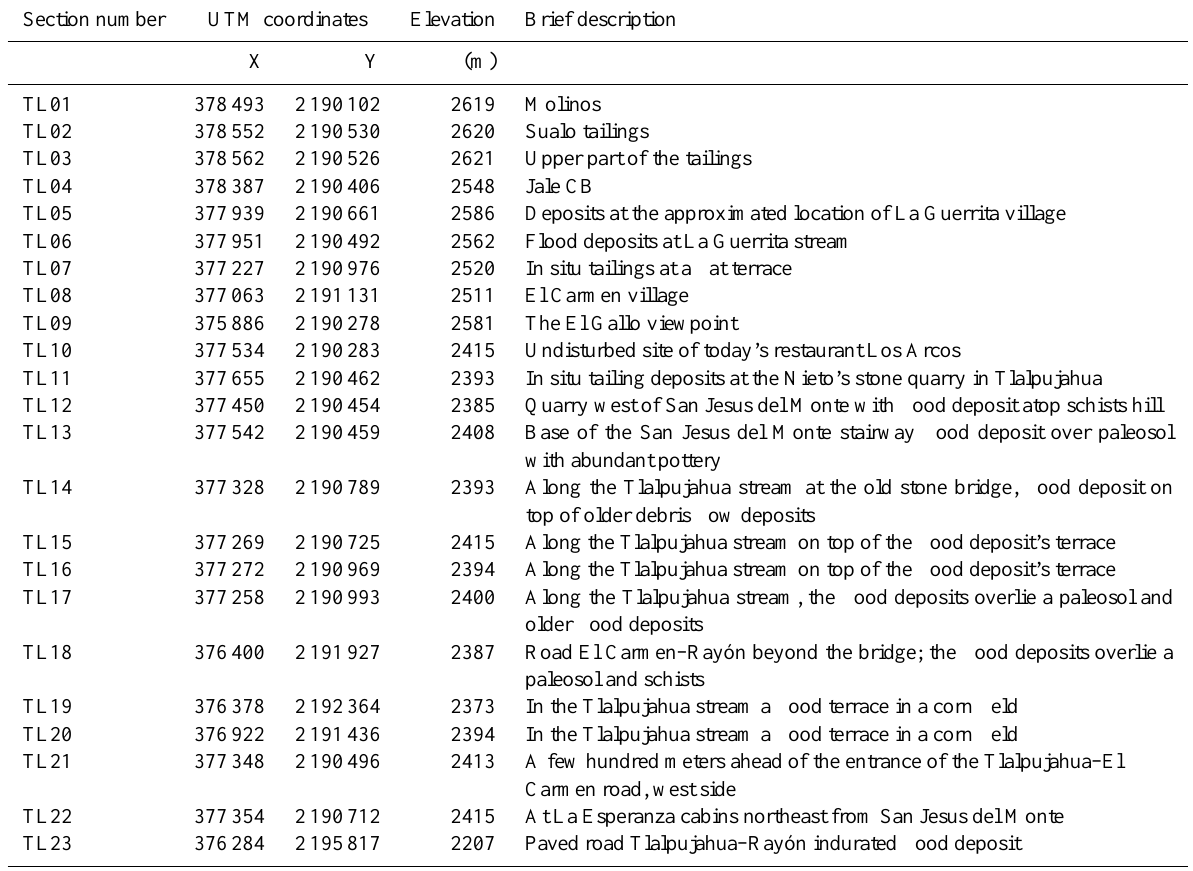
Table 2. List of stratigraphic sections along the Las Lamas food